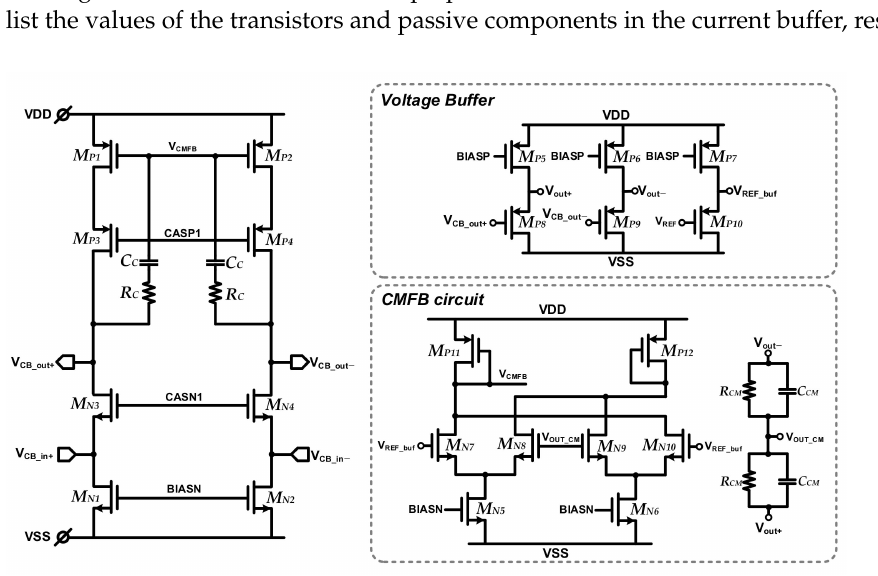
Figure 8. Schematic of the proposed current buffer in the RRL. Table 3. Values of transistors in the current